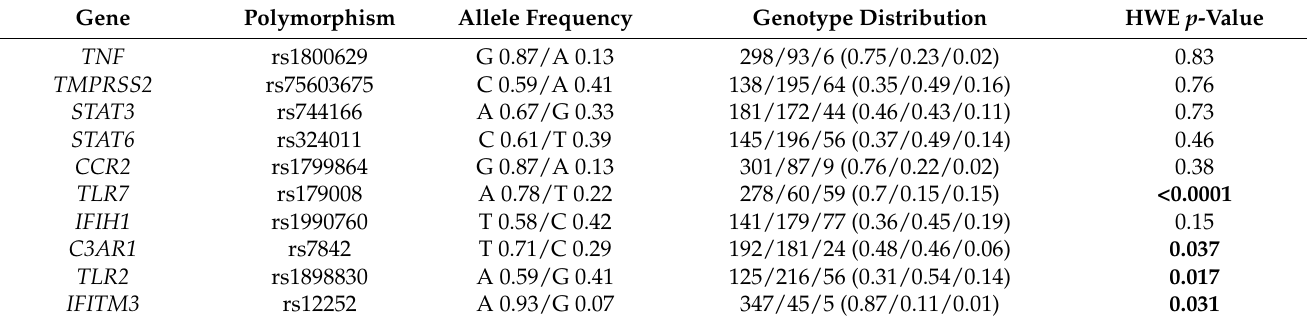
Table 4. Analysis of allele frequencies and genotype distribution with the Hardy–Weinberg equilib- rium (HWE).